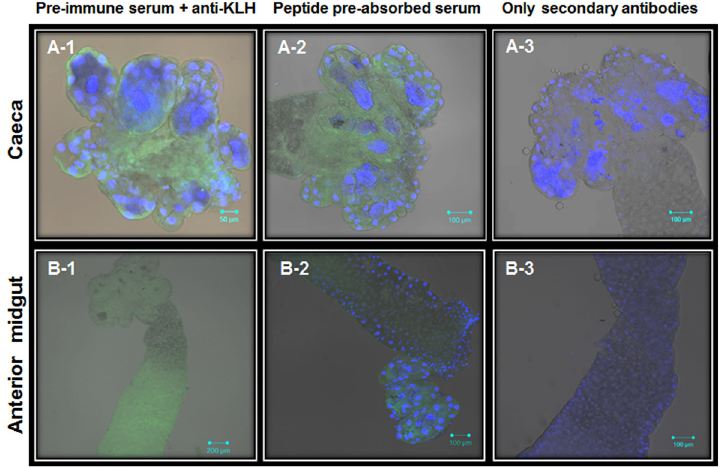
Fig 6. Specific AaSeR-1 immunofluorescence was not observed in the caeca and the anterior midgut of Aedes larvae when subjected to negative control analyses. Brightfield images of Aedes caeca (A) and anterior midgut (B) superimposed with green (Ex. 488) and blue fluorescence (DAPI — DNA specific, Ex. 405) were obtained from samples treated with (1) pre-immune serum (1:500) + anti-KLH antibody (1:10000), or (2) peptide pre-absorbed anti-AaSeR-1 antiserum (1:500) + anti-KLH antibody (1:10000), or (3) secondary antibodies (1:300). Lack of specific (strong) green fluorescence in the control tissues indicates that there is no cross-reactivity between negative control treatments and Aedes gut endogenous proteins. Scale bars ( μ M) are included in each image.